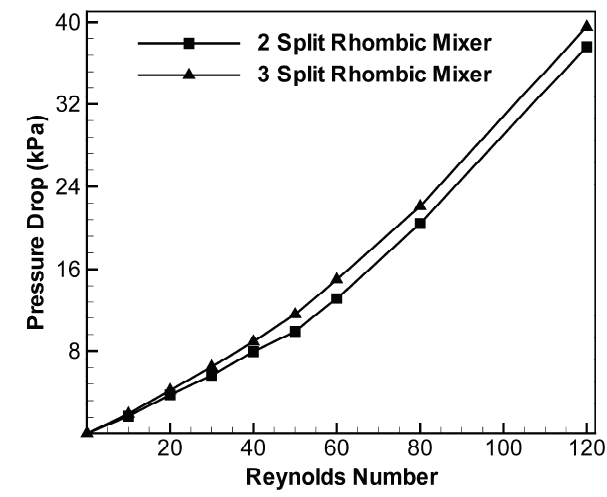
Figure 8. Variations of the pressure drop with Reynolds number in unbalanced two-split and three-split rhombic